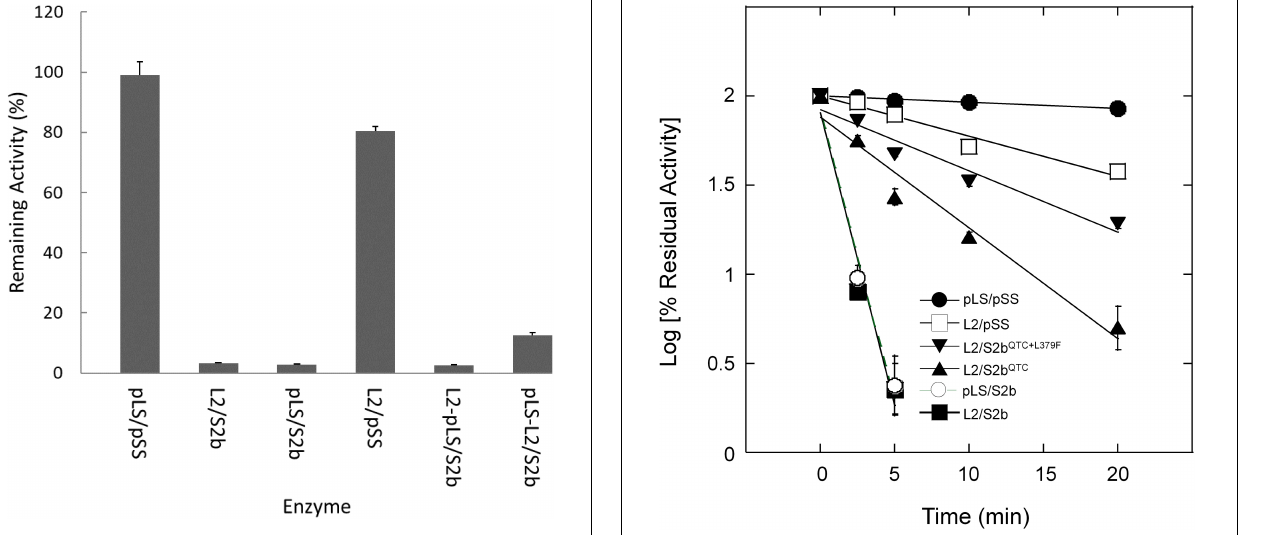
FIGURE 2 | Heat stability of AGPase variants at 55 ◦ C. Partially purified AGPase variants were assayed to measure their residual activity, i.e., the percentage of remaining enzyme activity after heat denaturation at 55 ◦ C for 5 min compared to that measured after incubation at 37 ◦ C for 5 min. The data are mean values ( ± SE) obtained from at least two independent experiments with two replicates performed at each experiment under standard reaction conditions (see section “Materials and Methods”).